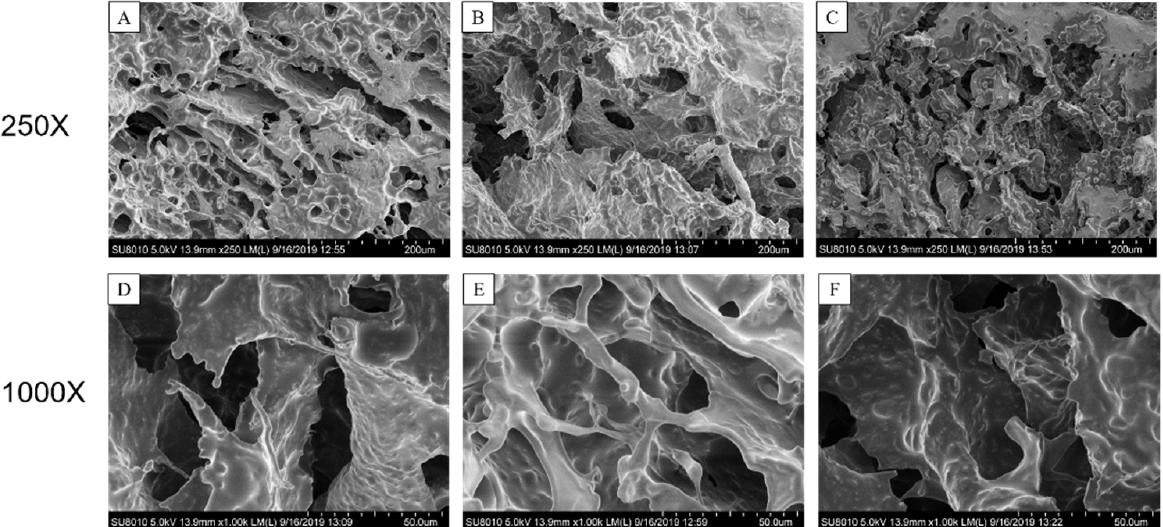
Figure 3. The SEM micrographs of SPI-SBP emulsion gels induced by laccase ( A ), L&GDL ( B ), and L&MTG ( C ) in 250×. ( D – F ) are a section of images ( A – C ) with higher magnification (1000×). In Figure 4, the green area of the CLSM result represents the FITC ‐ labeled SBP, the blue area represents rhodamine ‐ stained SPI, and the red area indicates Nile Red ‐ stained MCT oil droplets (red oil droplets appear purple due to superposition with blue protein).